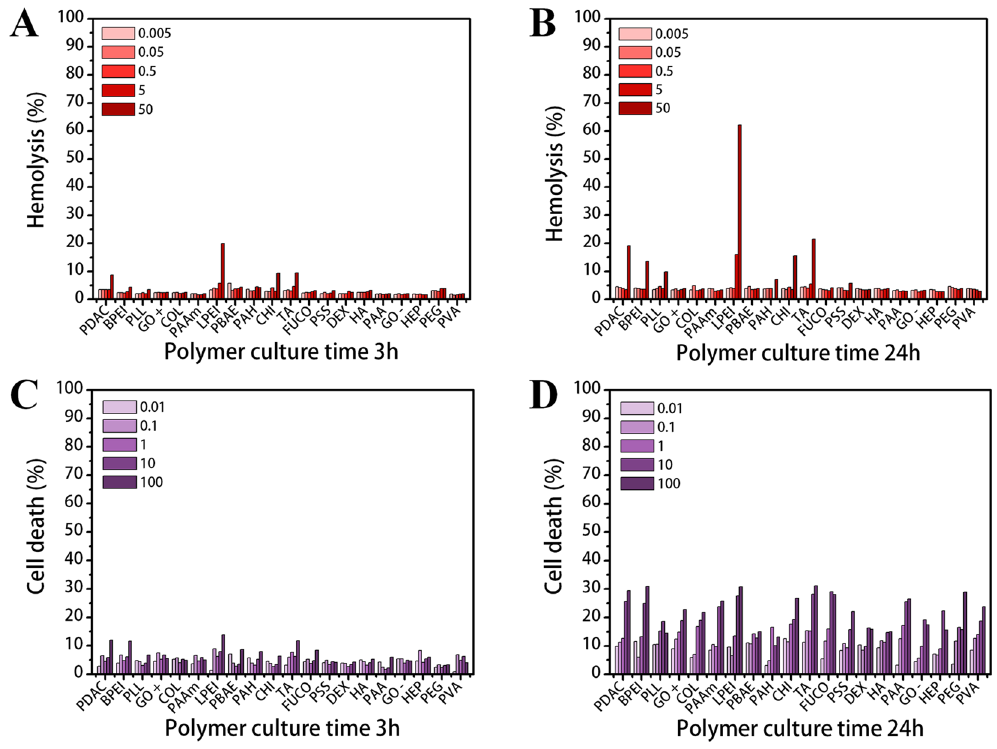
Figure 3. Cytotoxic effects of polymers on RBCs and PBMCs. Hemolysis ratios of different polymer concentrations ranging from 0.005 to 50 µ g/mL after ( A ) 3 h and ( B ) 24 h. Cell death ratios after exposure to five polymer concentrations from 0.01 to 100 µ g/mL for ( C ) 3 h and ( D ) 24 h. The negative control is